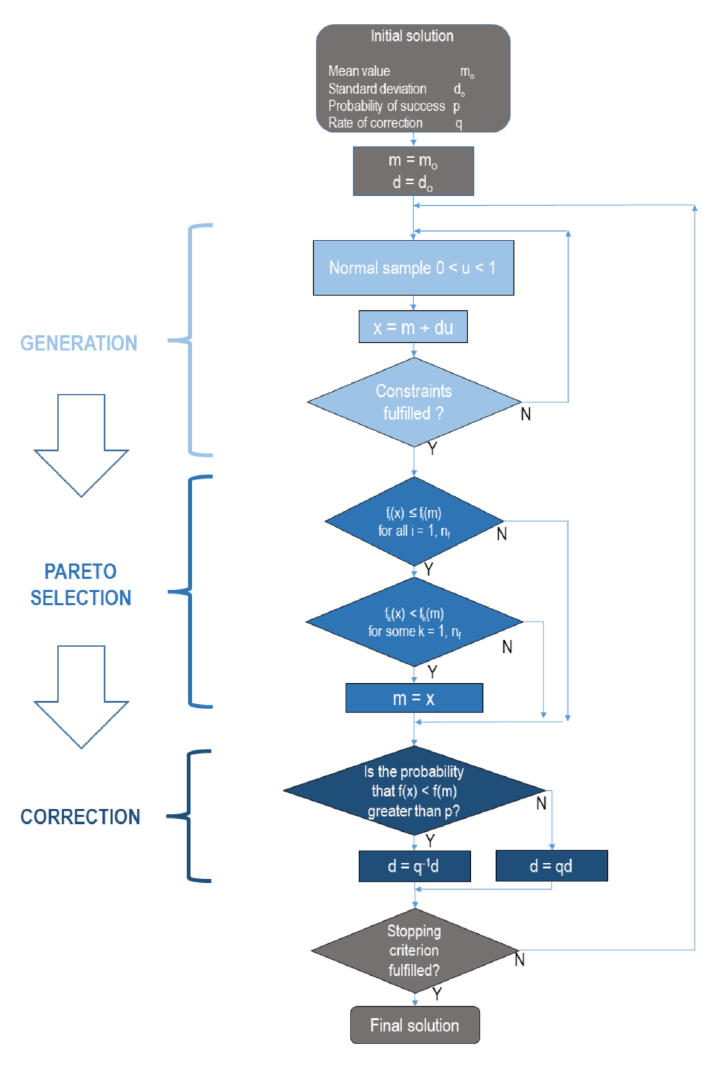
Figure 6. Flow-chart of P-EStra